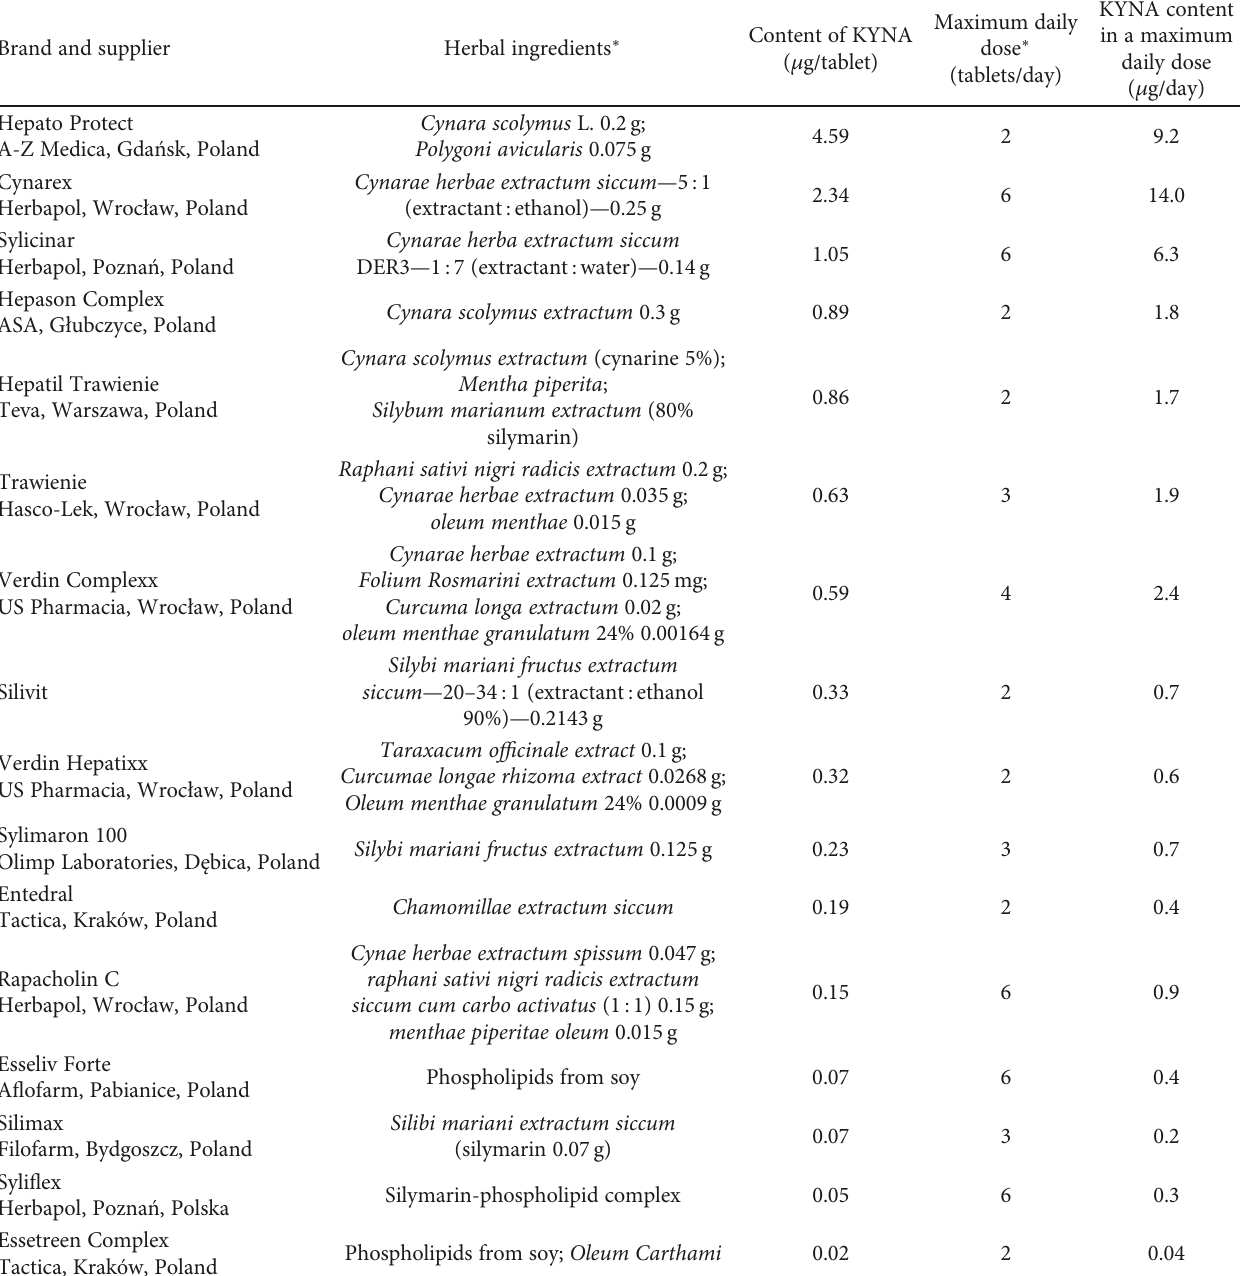
Table 1: Content of kynurenic acid (KYNA) in hepatoprotective herbal medicines. Brand and supplier Herbal ingredients